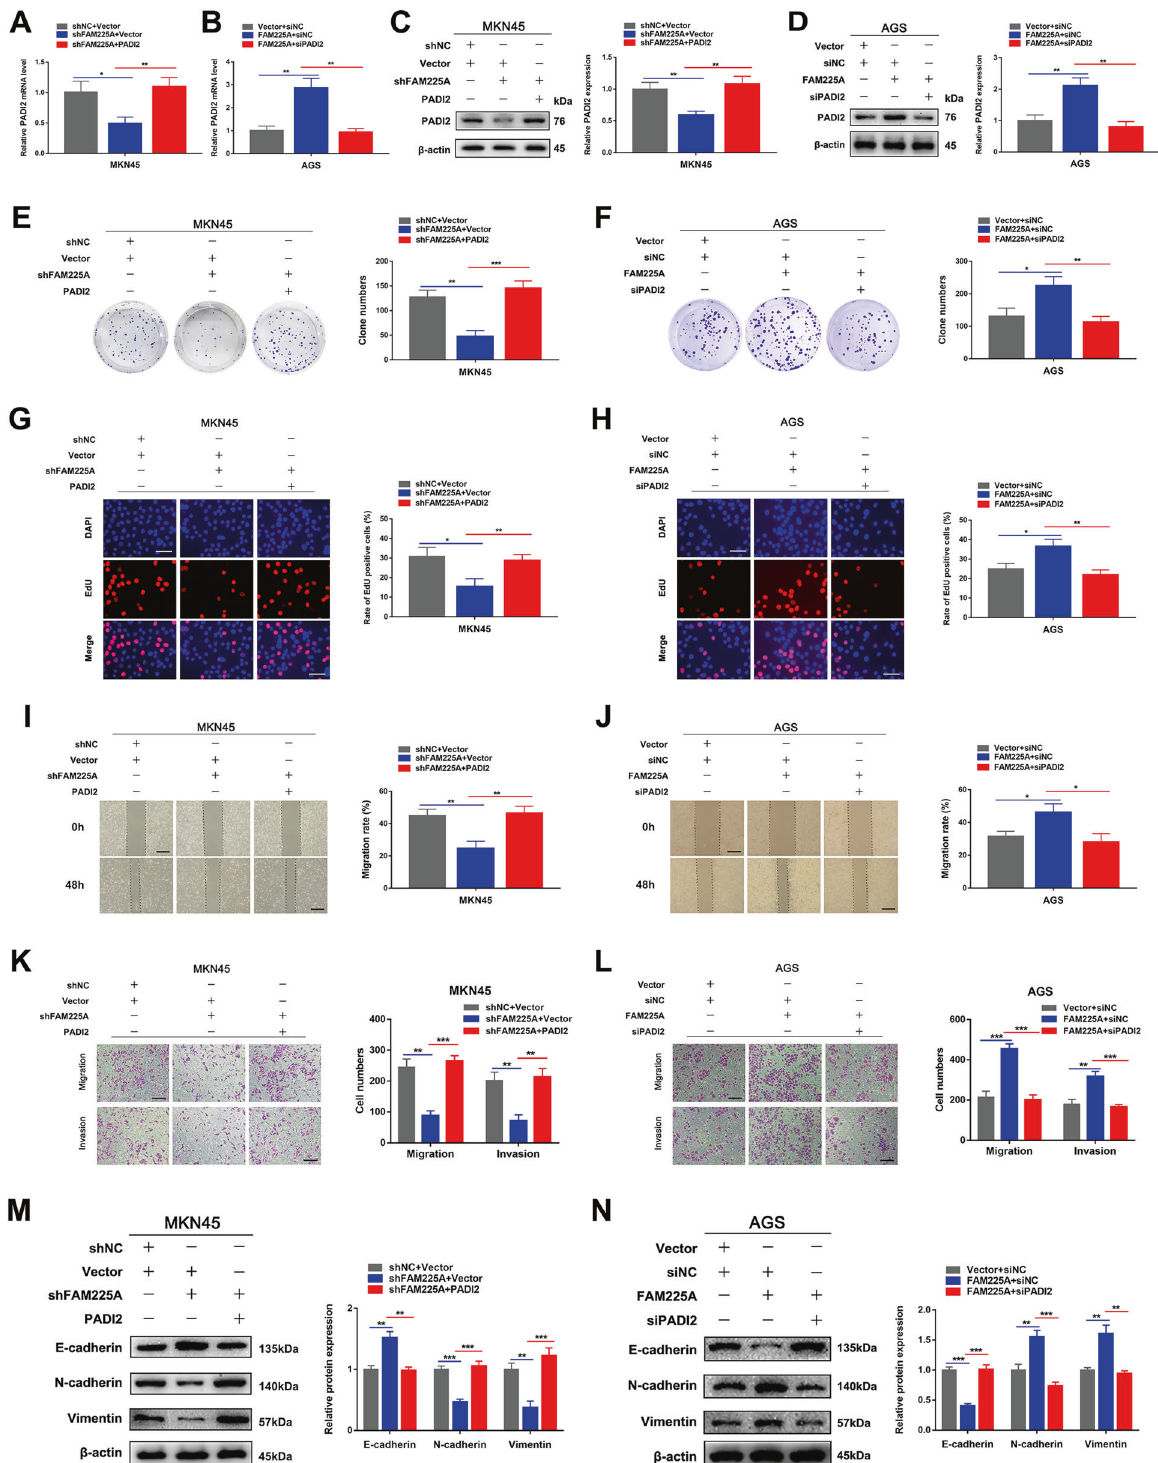
Fig. 7 The effect of FAM225A on GC cell proliferation, migration, and invasion could be reversed by PADI2. A – D Detecting PADI2 mRNA and protein expression when MKN45 cells transfected with siNC + Vector, siFAM225A + Vector, siFAM225A + PADI2, or when AGS cells transfected with Vector + siNC, FAM225A + siNC, FAM225A + siPADI2 by using qRT-PCR and western blot. E – H Colony formation assay and edu assay demonstrated that knockdown of FAM225A mediated inhibition of MKN45 cell proliferation were partially rescued by overexpression of PADI2, and silencing PADI2 could partially counteract overexpression of FAM225A mediated promotion of AGS cell proliferation (scale bar: 100 μ m for Edu). I – L Detecting the cell migration and invasion ability after transfecting GC cells through wound healing assays and transwell assays (scale bar: 200 μ m for transwell assay, 100 μ m for wound healing assay). M , N Western blot analysis of the EMT-related molecules in different treatment groups. p values were obtained by Student ’ s t test. Data are presented as means ± SD. * p < 0.05, ** p < 0.01, *** p <